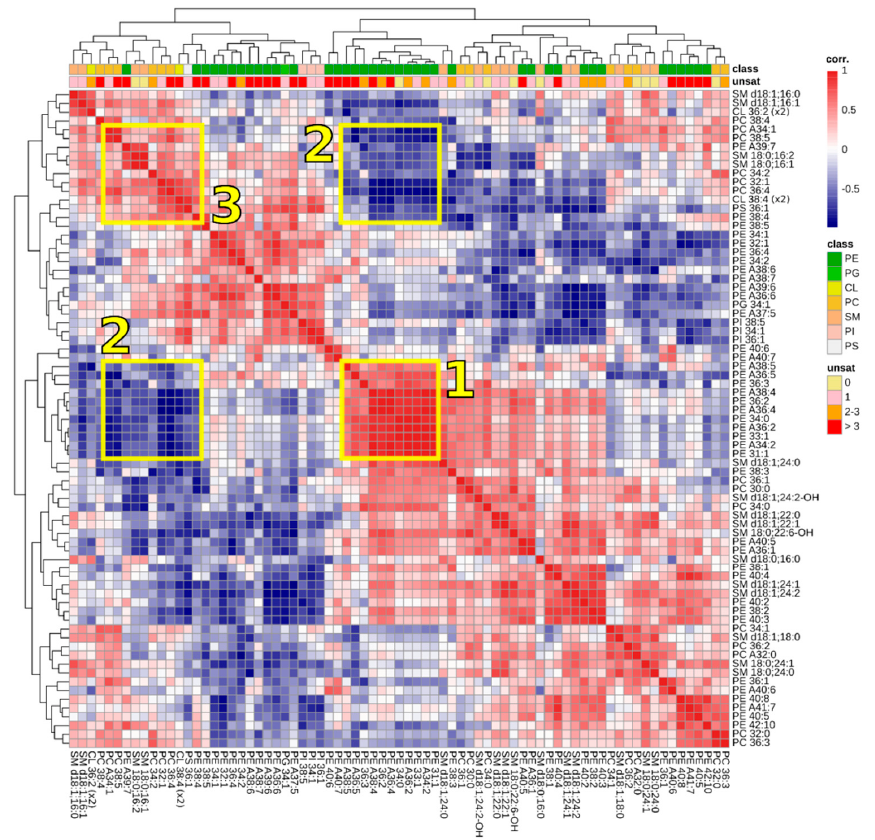
Figure 4. Heatmap of lipid-lipid correlations. The 75 most abundant lipid signals were ordered using hierarchical clustering. Correlations between lipid species are colored from strong positive correlation (red), to no correlation (white), to negative correlation (blue). The boxed areas 1–3 are discussed in the main text.